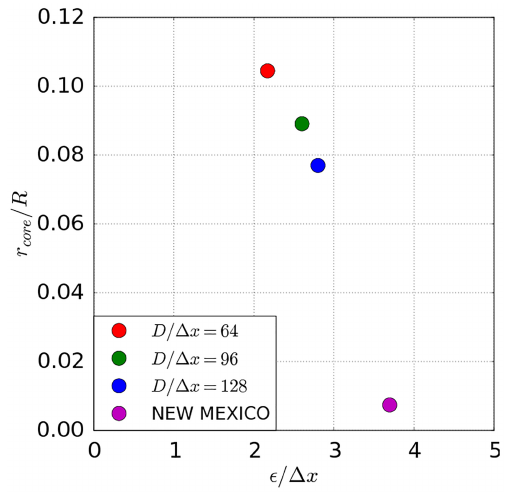
Figure 10. Normalized vortex radius r core /R over normalized dis- tribution parameter (cid:15)/(cid:49)x .